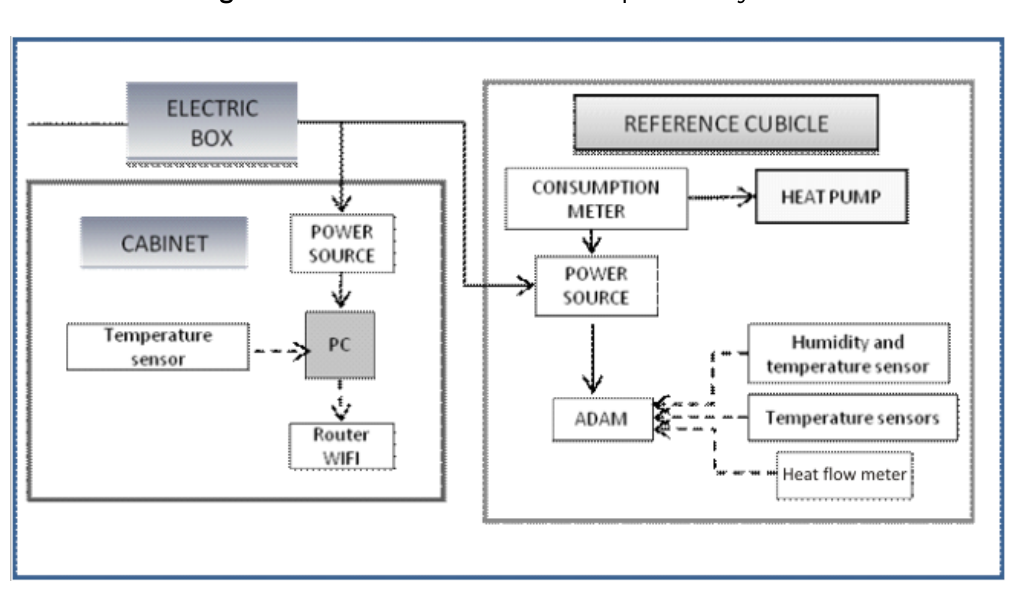
Figure 3. Flow chart of the data acquisition